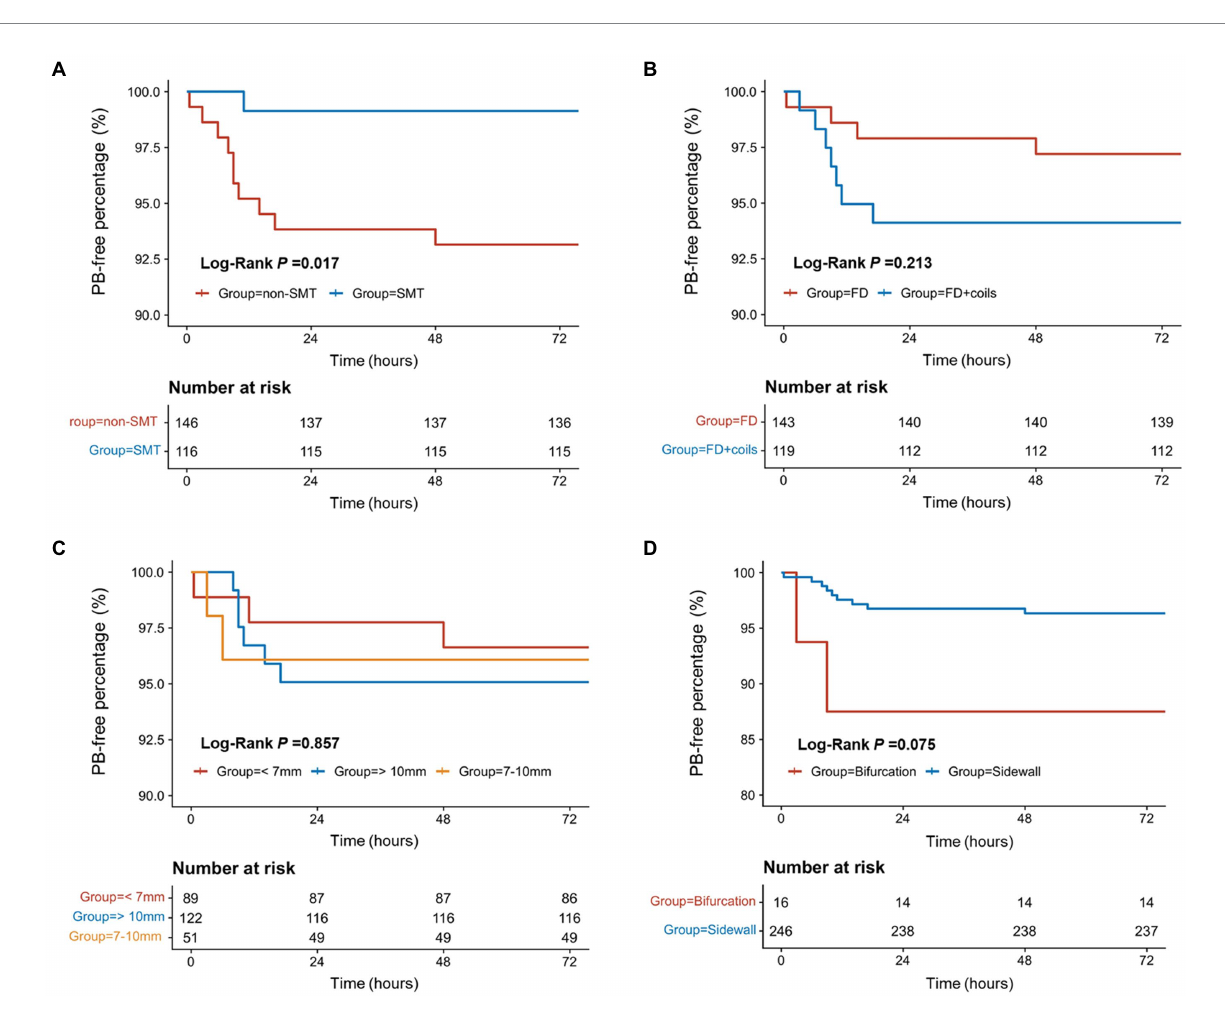
FIGURE 2 The survival analysis for the factors related to postoperative bleeding. (A) The survival analysis of SMT/non-SMT for PB. (B) The survival analysis of surgical methods for PB. (C) The survival analysis of different aneurysm sizes for PB. (D) The survival analysis of bifurcation/sidewall for PB. PB, postoperative bleeding; SMT, standard methylprednisolone treatment; FD, flow